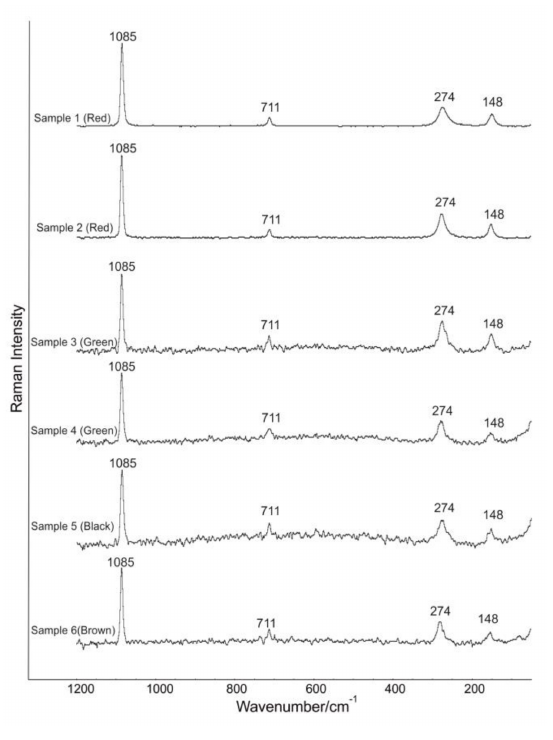
Figure 6. Raman spectra of calcite for all